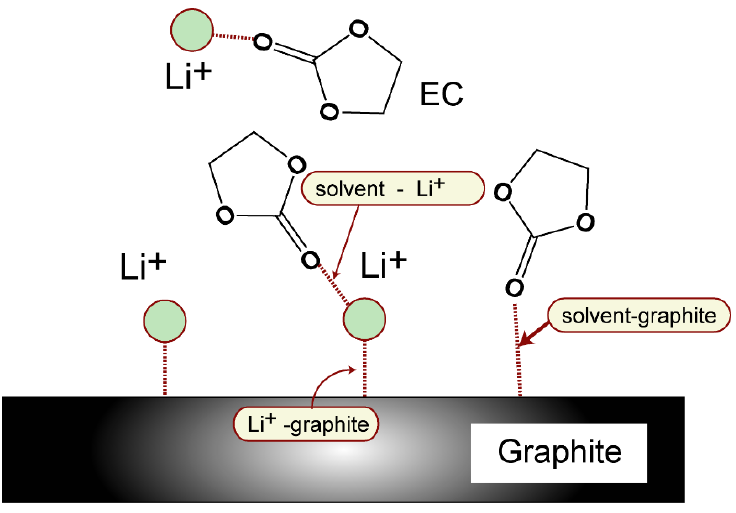
Figure 1. Schematic illustration of the types of interactionsin the graphene-ethylene carbonate (EC)-lithium system.